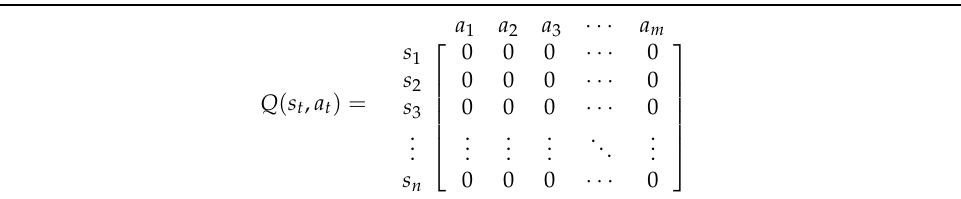
Figure 6. The model framework of the Q -learning algorithm. Table 6. Initial Q value